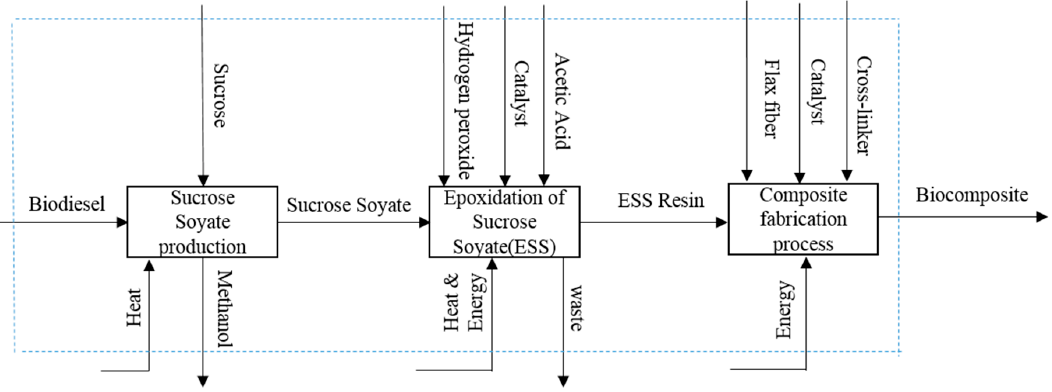
Figure 1. Process flow for the production of ESS and ESS-based biocomposite, the dashed line indicates the system boundary.